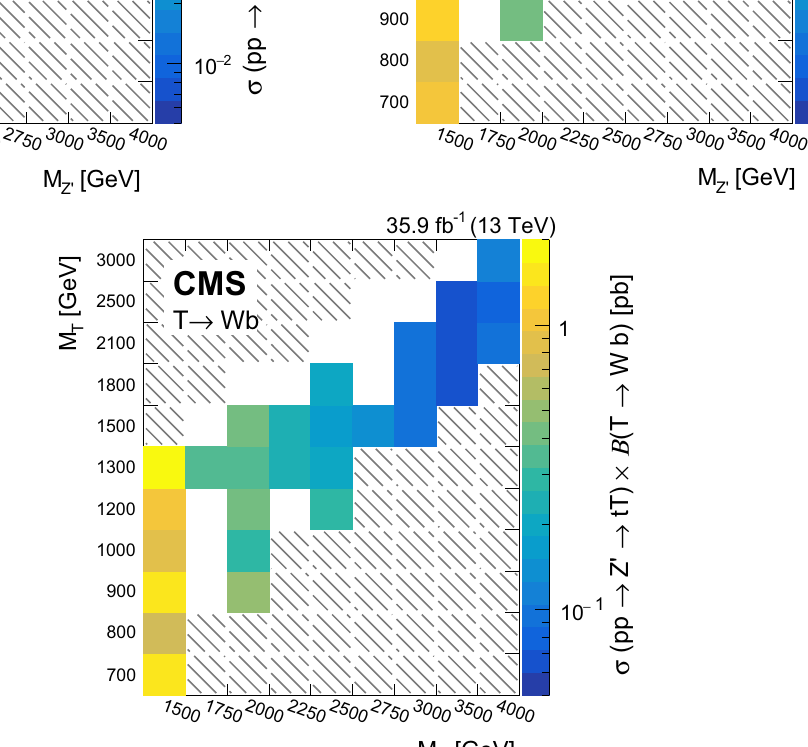
decay is kinematically forbidden, while in the lower right Z (cid:3) → tT is suppressed by the preferred Z (cid:3) → TT mode. White areas